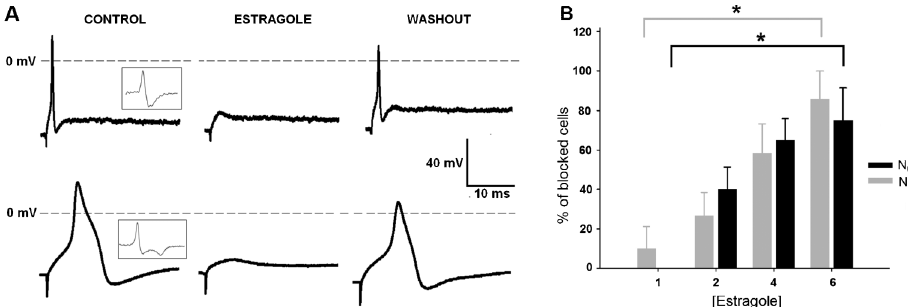
Figure 1. Effects of estragole on action potential recorded in N 0 and N inf cells. Tracings in panel A show the effect of 4 mM estragole on action potentials; insets show first derivative of voltage responses. Panel B shows the percentage of neurons blocked by estragole (1.0- 6.0 mM). The total number of cells was 8, 20, 20, and 8 for N 0 , and 10, 15, 12, and 7 cells for N inf , for each estragole concentration, respectively. Data are reported as means±SE. *P , 0.05, chi-square test.